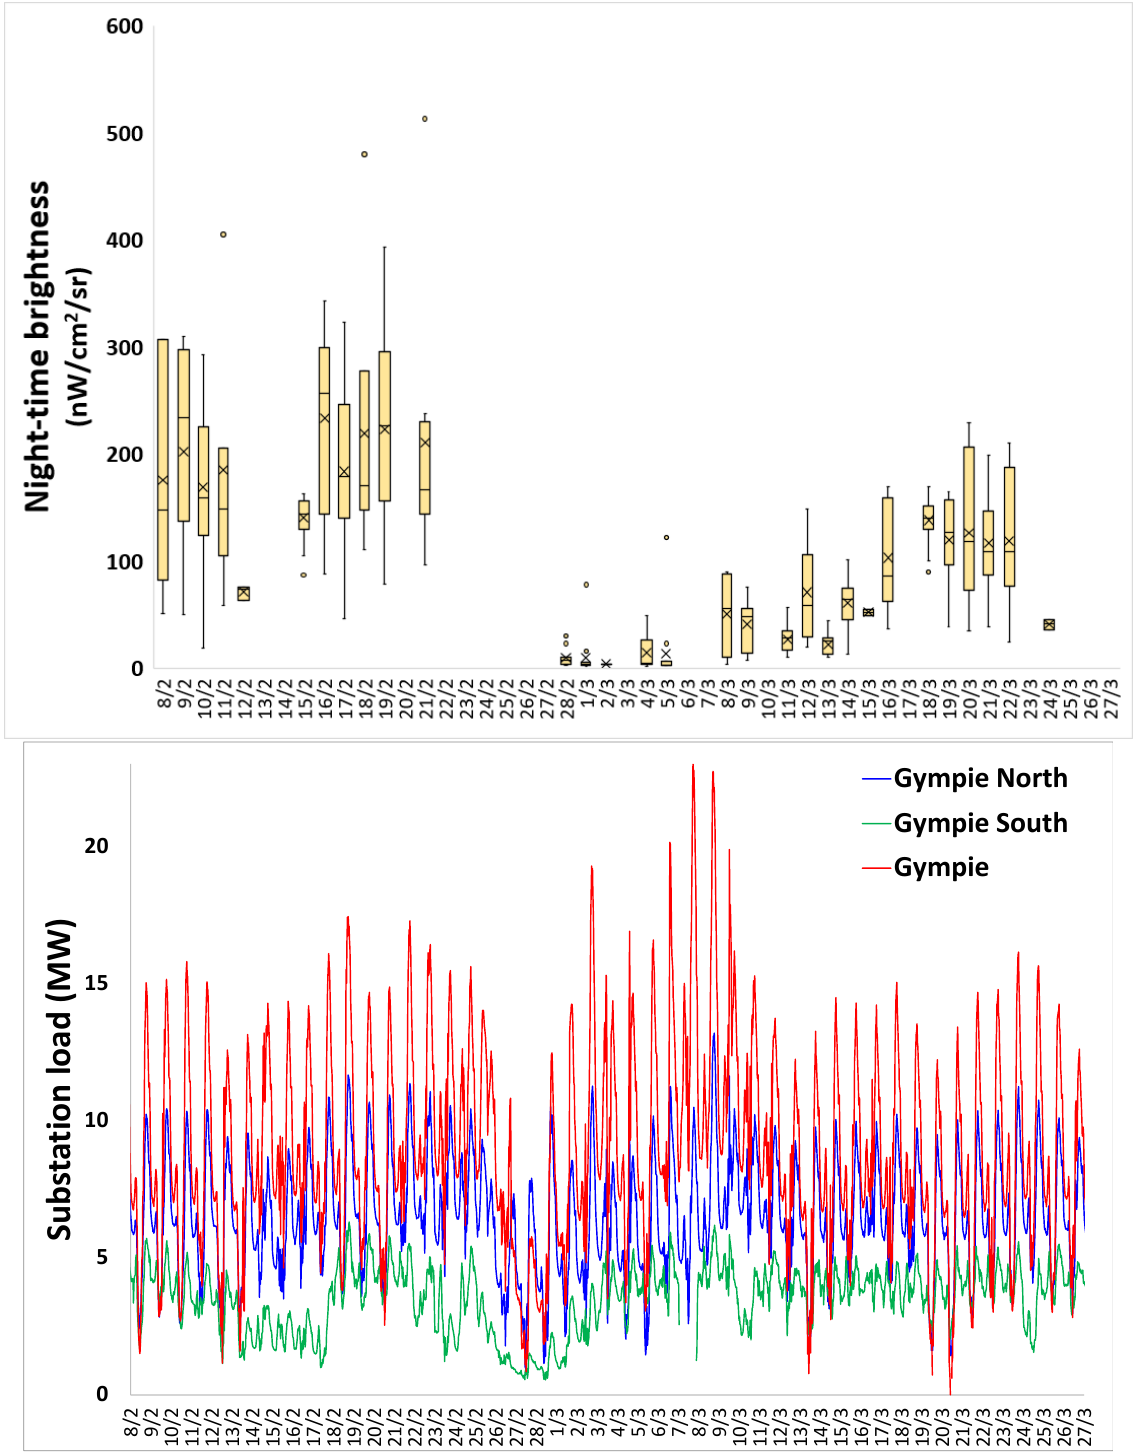
Figure 11. Top: Box plot of nighttime brightness for 16 VIIRS grid cells in Gympie where there was a statistically significant difference in nighttime brightness between period 1 and period 2. Bottom: Substation electricity loads (half-hourly data from Energex) for three substation zones covering Gympie. The boxplot only includes cloud-free data.